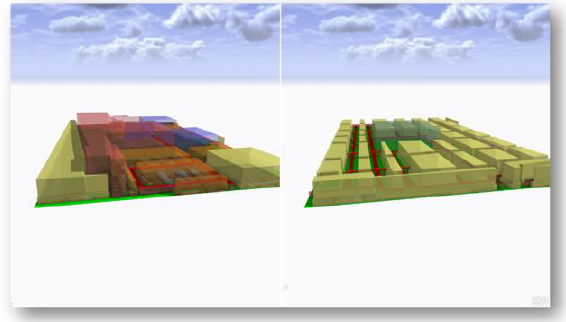
Figure 11. Comparison view for the zoning scenarios